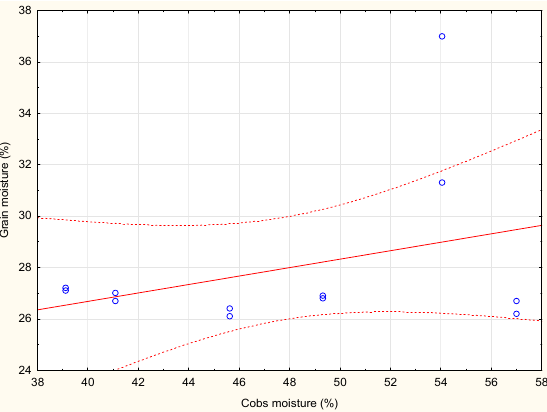
Figure 1 . Correlation between corn cobs moisture and corn grain moisture (r = 0.34). Figure 1. Correlation between corn cobs moisture and corn grain moisture (r =